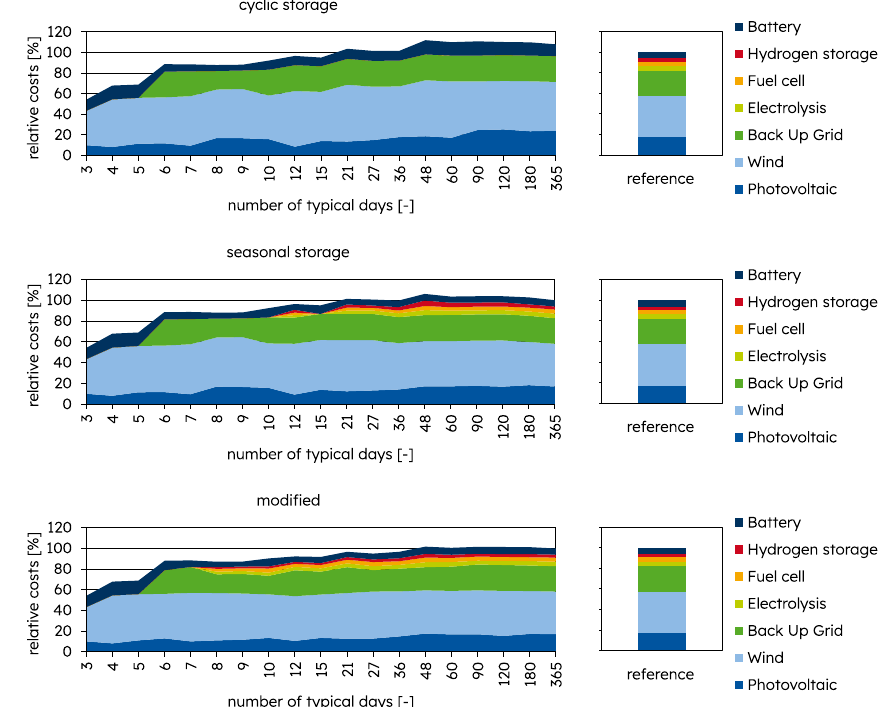
Fig. 6 Comparison of total costs share for cyclic and seasonal storage model for Island